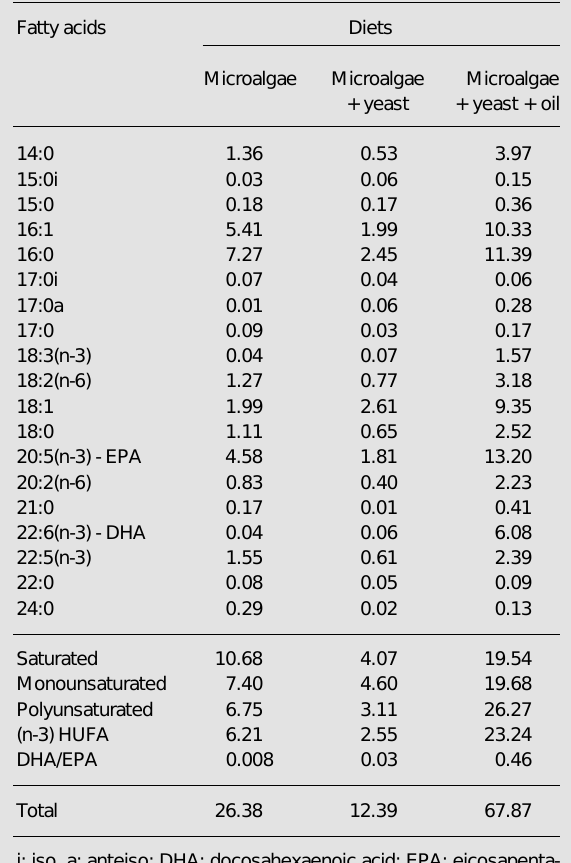
Table 1. Fatty acid content (mg/g dry weight) of rotifers fed on different diets and used as feed for fat snook larvae. Fatty acids